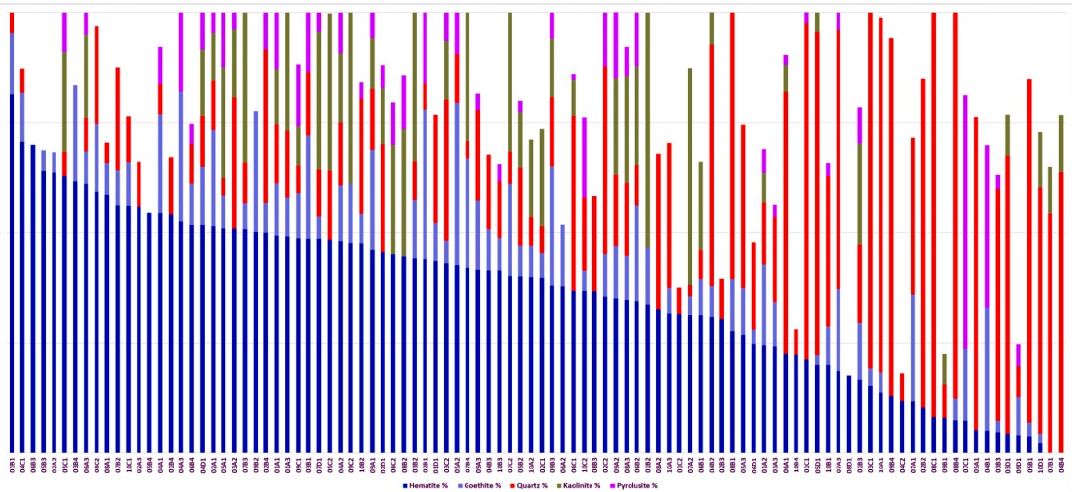
Figure 5. Mineralogical composition summary of 100 samples. The main minerals in Joda West mine samples are hematite, quartz, goethite, kaolinite and pyrolusite.